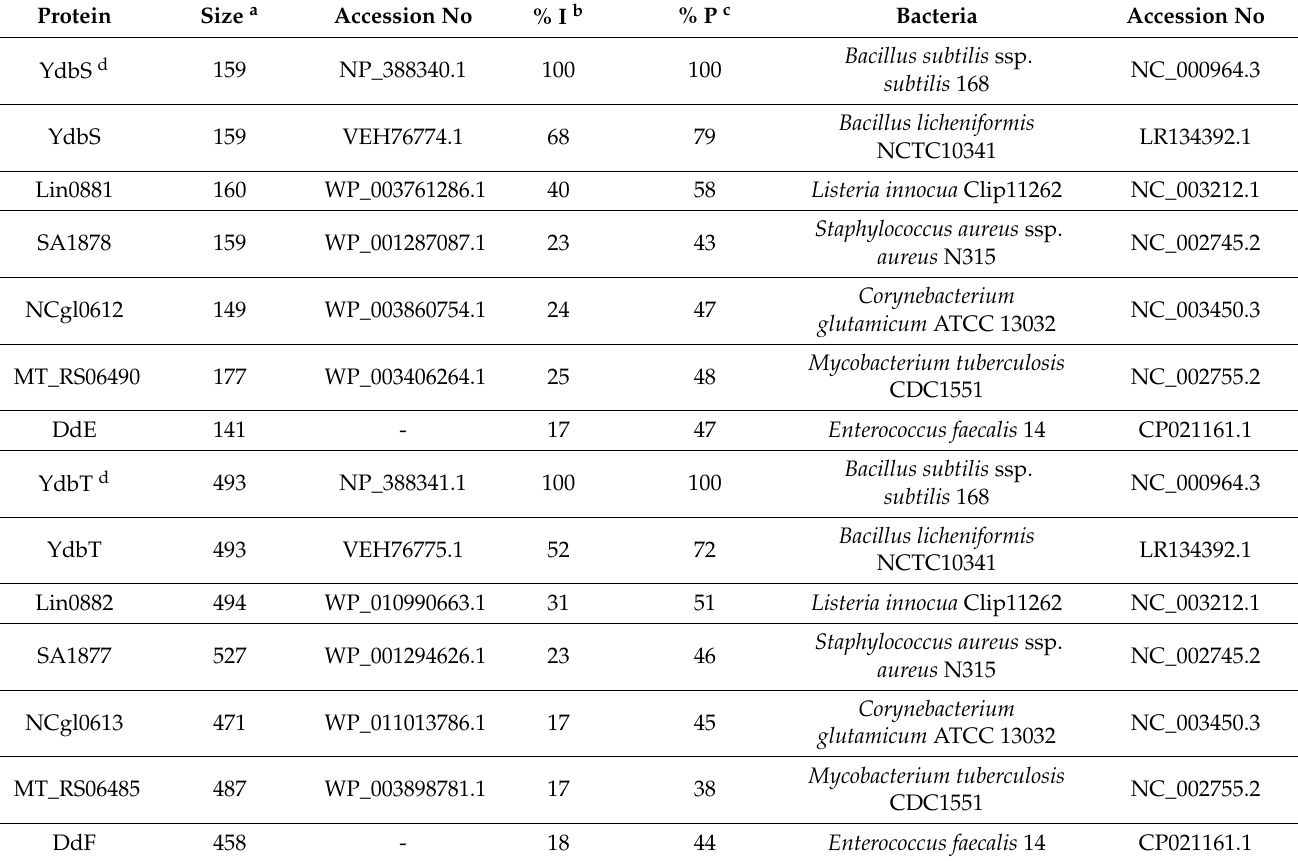
Table 1. Members of the bacterial proteins families YdbS and YdbT containing PH b 2 domains from Bacillus subtilis ssp. subtilis